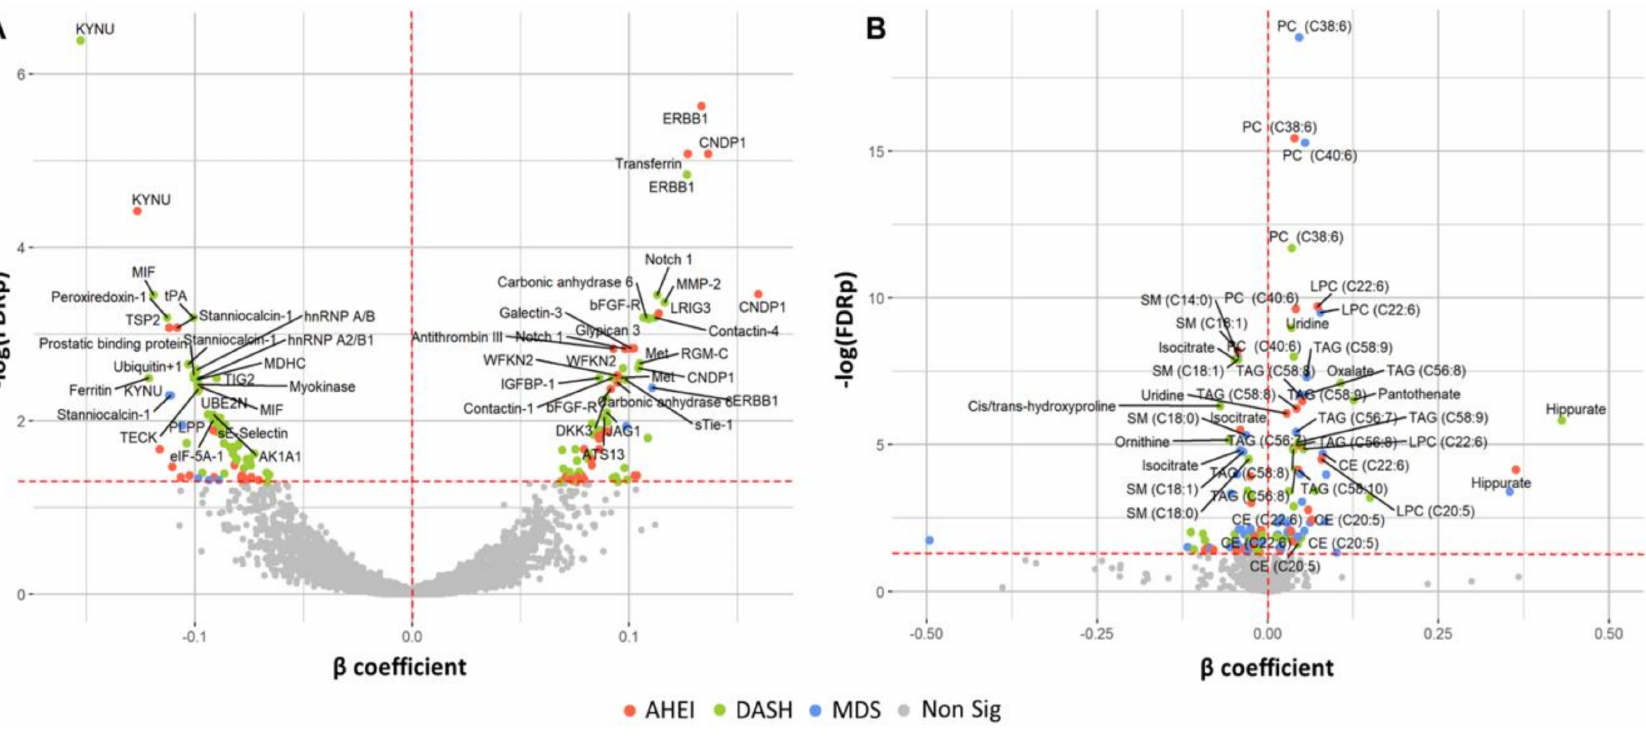
Figure 2. Protein ( A ) and metabolite ( B ) markers associated with dietary pattern indices. Colored points (red, green, blue) indicate statistical significance (FDR q ≤ 0.05) by the respective dietary pattern indices. Multivariable regression models are adjusted for age, sex, total caloric intake, current smoking, physical activity index, lipid lowering medication, anti-hypertensive medication, and body mass index. β estimates represent the change in marker per one-unit increase in the respective dietary pattern indices. Eleven metabolites with β coe ffi cients < − 0.50 or > 0.50 are excluded from the figure. Abbreviations: AHEI, Alternative Healthy Eating Index; CE, cholesterol ester; DASH, Dietary Approaches to Stop Hypertension; FDR, false discovery rate; LPC, lysophosphatidylcholine; LPE, lysophosphatidylethanolamine; MDS, Mediterranean-style Diet Score. PC, phosphatidylcholine; SM, sphingomyelin; TAG,